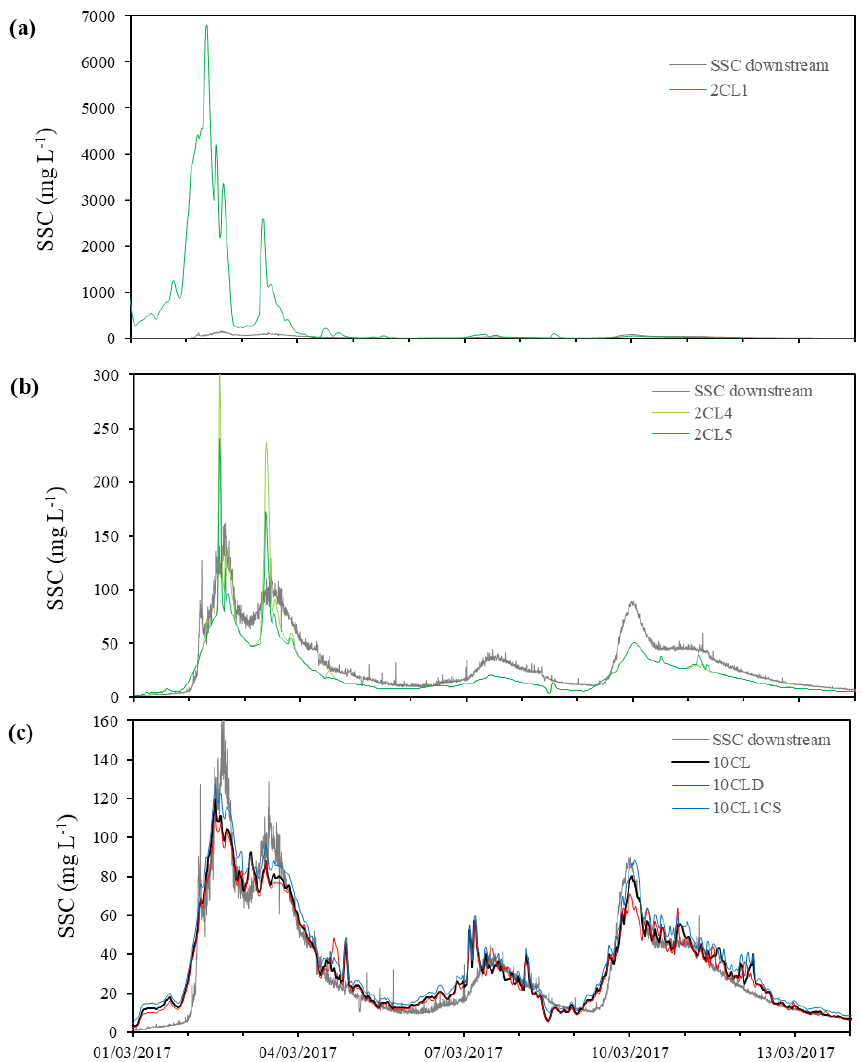
Figure 6. Simulated and measured suspended sediment concentration time series at the downstream boundary for configurations (a) 2CL (first run); (b) 2CL (fourth and fifth runs); and (c) 10CL, 10CLD, and 10CL1CS. SSC: suspended sediment concentration. 10CL, 10CLD, 10CL1CS, 2CL1, 2CL4, and 2CL5: various modelling scenarios (please refer to Table 1).